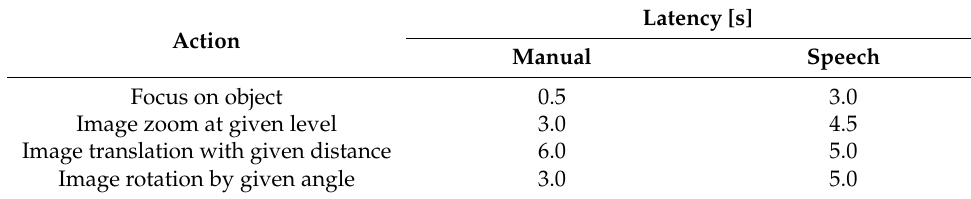
Table 2. Effectiveness of vision system actions controlled manually and by